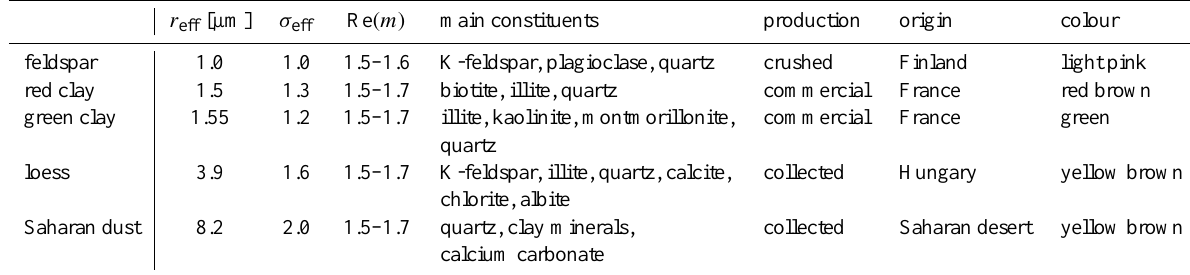
Table 1. Summary of the sample properties. The r eff and σ eff values have been computed from the measured size distribution; the Re( m ) is an estimate; Im( m) is estimated to be between 10 − 2 and 10 − 5 for all